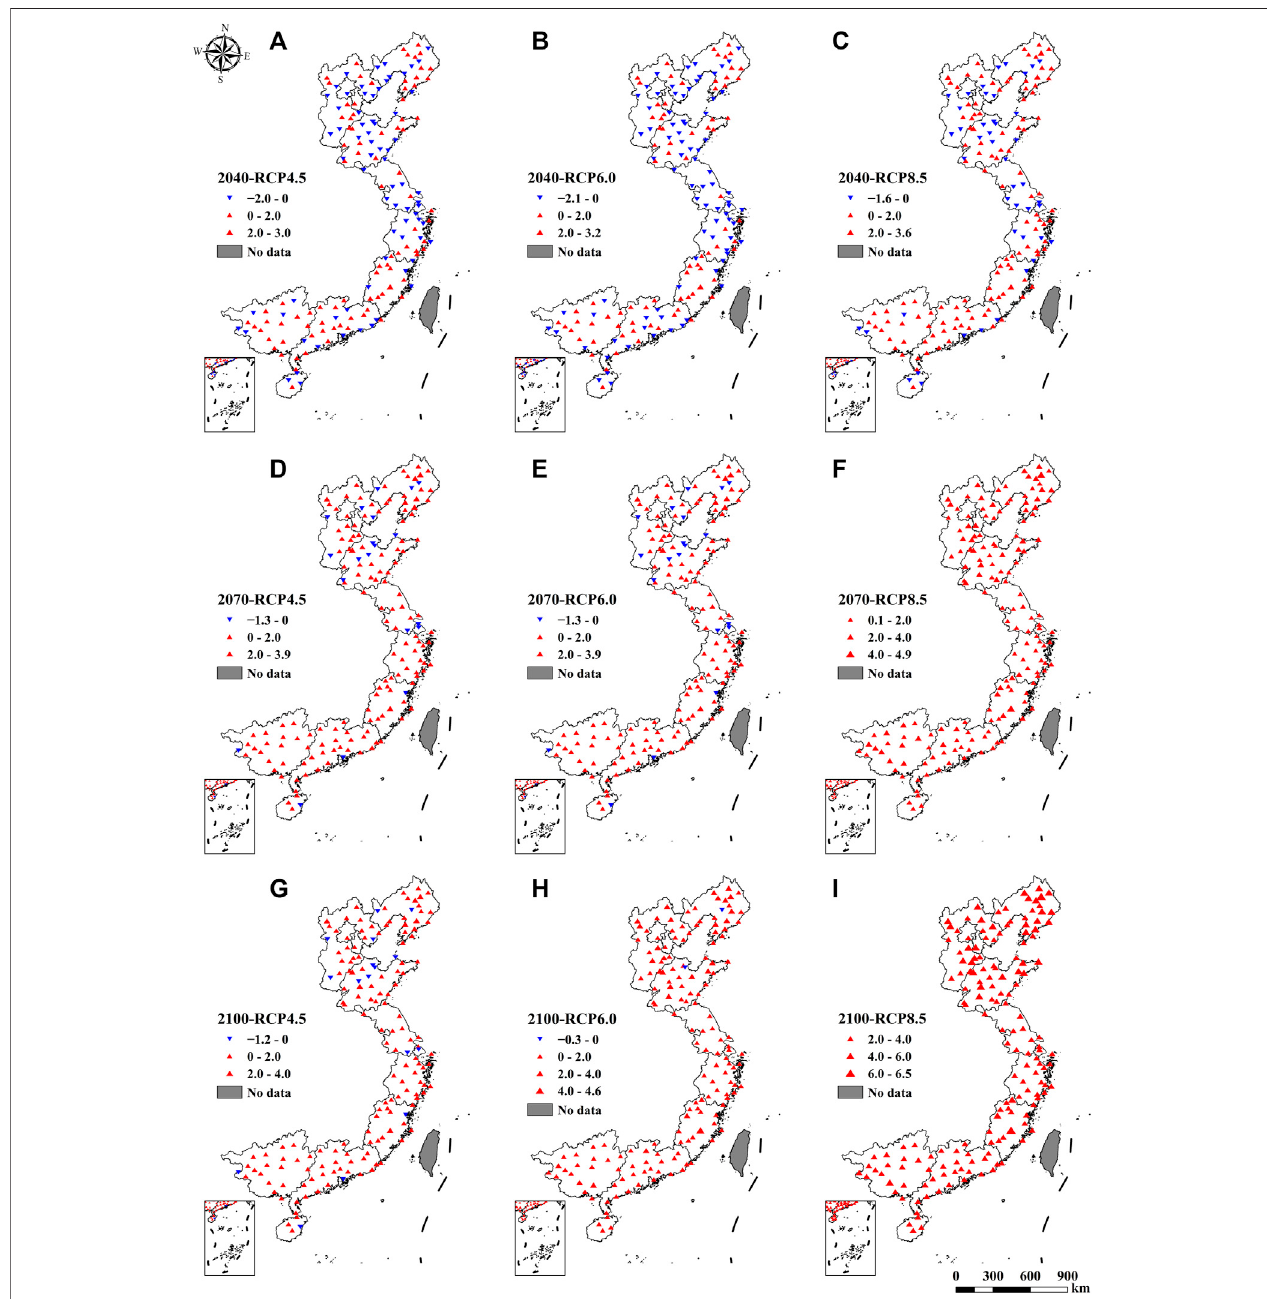
FIGURE9| SpatialdistributionofchangesinannualaverageTminfor2040withRCP4.5 (A) ,RCP6.0 (B) ,RCP8.5 (C) ,2070withRCP4.5 (D) ,RCP6.0 (E) ,RCP8.5 (F) and 2100 with RCP4.5 (G) , RCP6.0 (H) , RCP8.5 (I) relative to the base period 1996 -2018 at 162 meteorological stations over CAC.